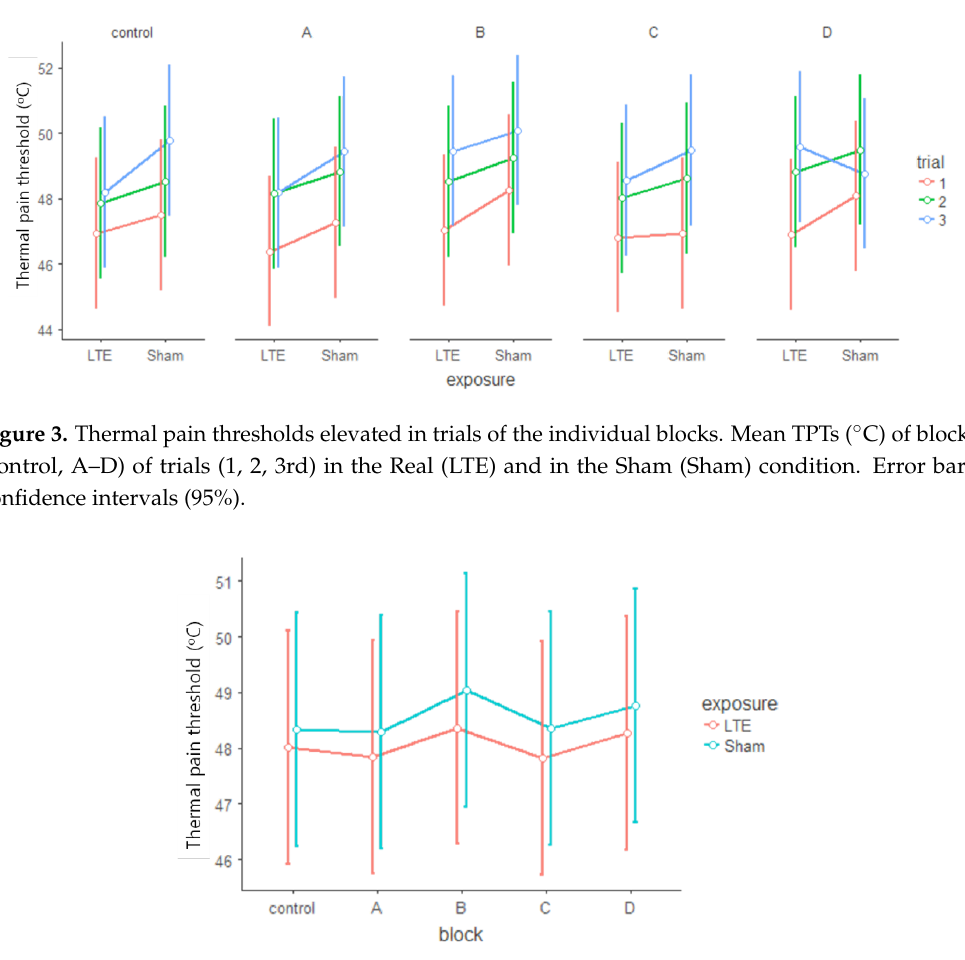
Figure 4. Thermal pain thresholds of the Real and Sham exposure did not differ. Mean TPTs (°C) of blocks (control, A–D) in the Real (LTE) and in the Sham (Sham) condition. Error bars: confidence intervals (95%).